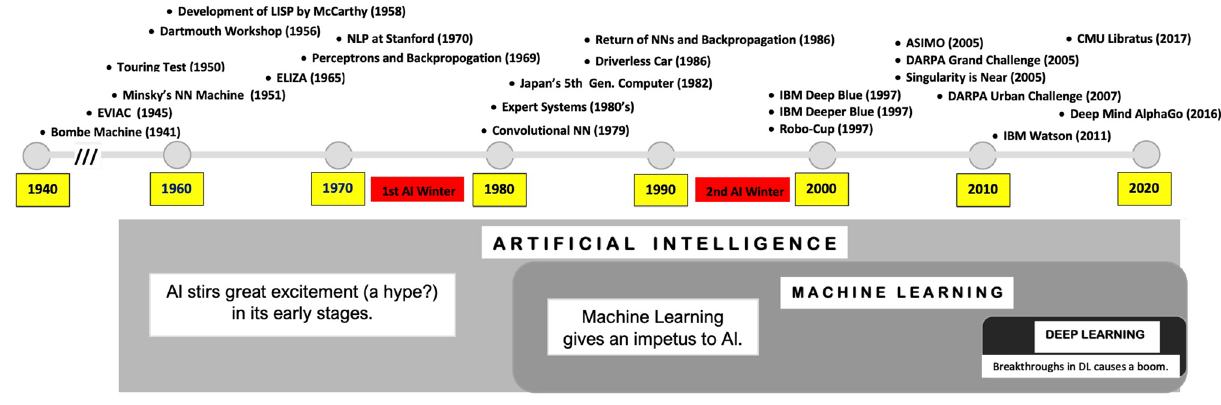
Fig. 2 The timeline of AI (copied with permission from